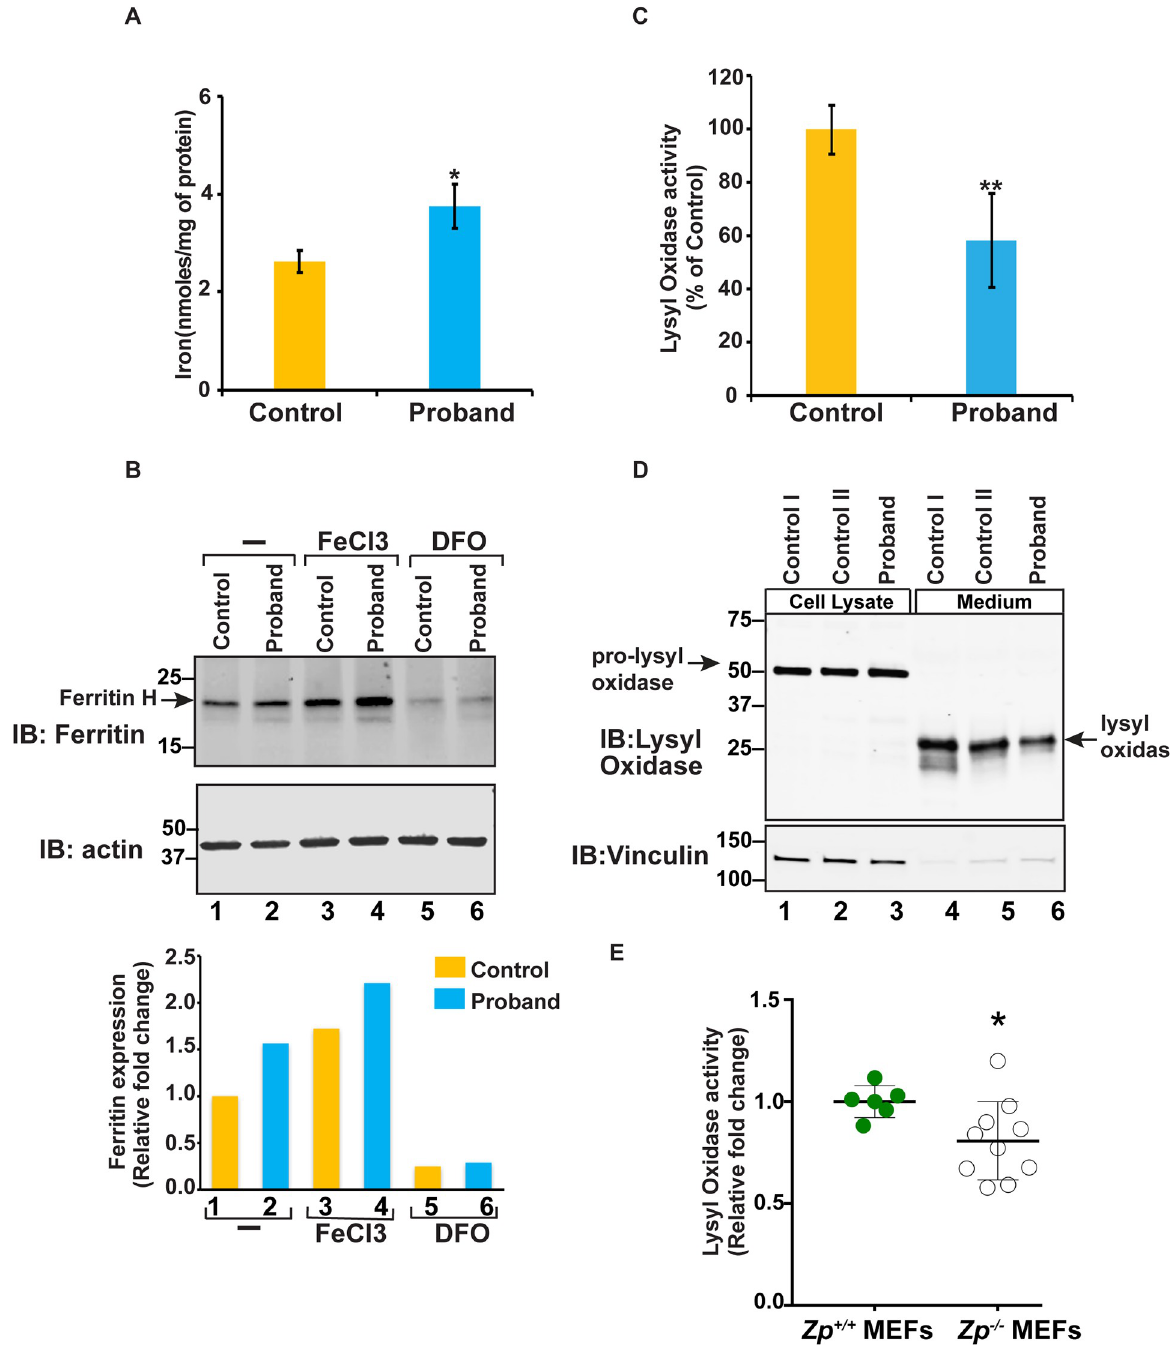
Fig 4. Functional consequences of the loss of HEPHL1. (A) Increased total intracellular iron content in the patient’s fibroblasts compared to control. The control value represents the mean of data from two independent normal cell lines (error bars indicate ± SD, n = 8, � p < 0.05). (B) Upper panels showing a representative anti-ferritin immunoblot of whole cell extracts of fibroblasts either untreated or treated with either 100 μ M FeCl 3 or 100 μ M DFO (top). Anti-ß actin immunoblot shows equivalent loading of lysates (bottom). Lower panel shows fold changes in expression, calculated by quantitative analysis of bands using image studio software (Li-COR Biosciences). (C) Reduced lysyl oxidase enzyme activity in the patient’s fibroblast. Lysyl oxidase activity was measured using a fluorescent enzyme assay. Each sample was measured in triplicate, and enzyme activity was normalized to total cellular protein content for each sample. Results are expressed as percentage of lysyl oxidase activity in patient’s fibroblasts relative to control. Control represents mean value of four independent normal cell lines (error bars indicate ± SD, n = 13, �� p < 0.0001). (D) Reduced levels of secreted lysyl oxidase in patient’s fibroblasts. Equal amounts of cell culture medium from two controls and patient’s